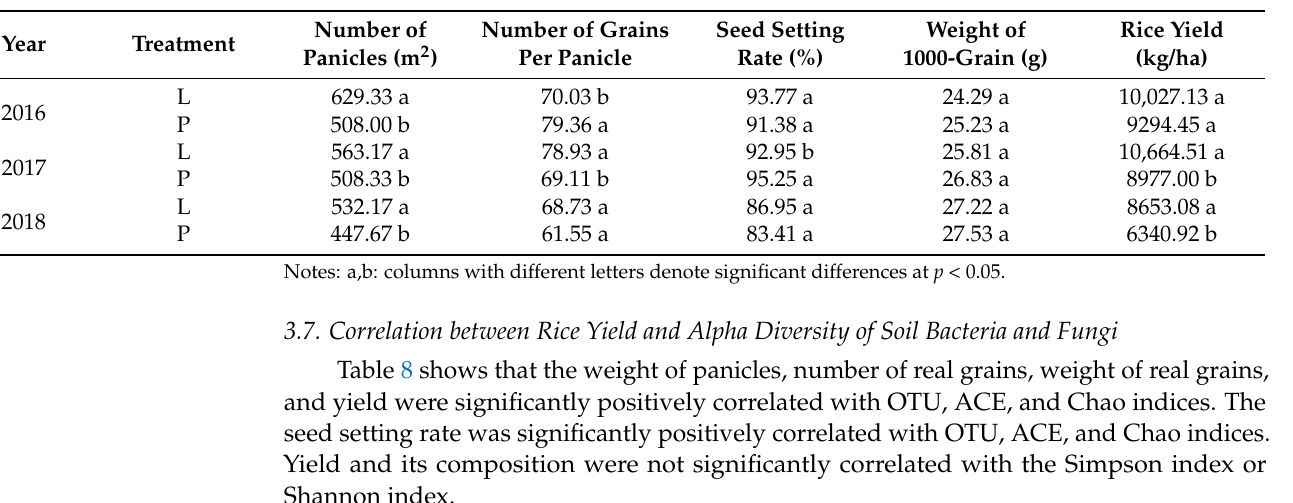
Table 7. Comparison of rice yield and yield components.